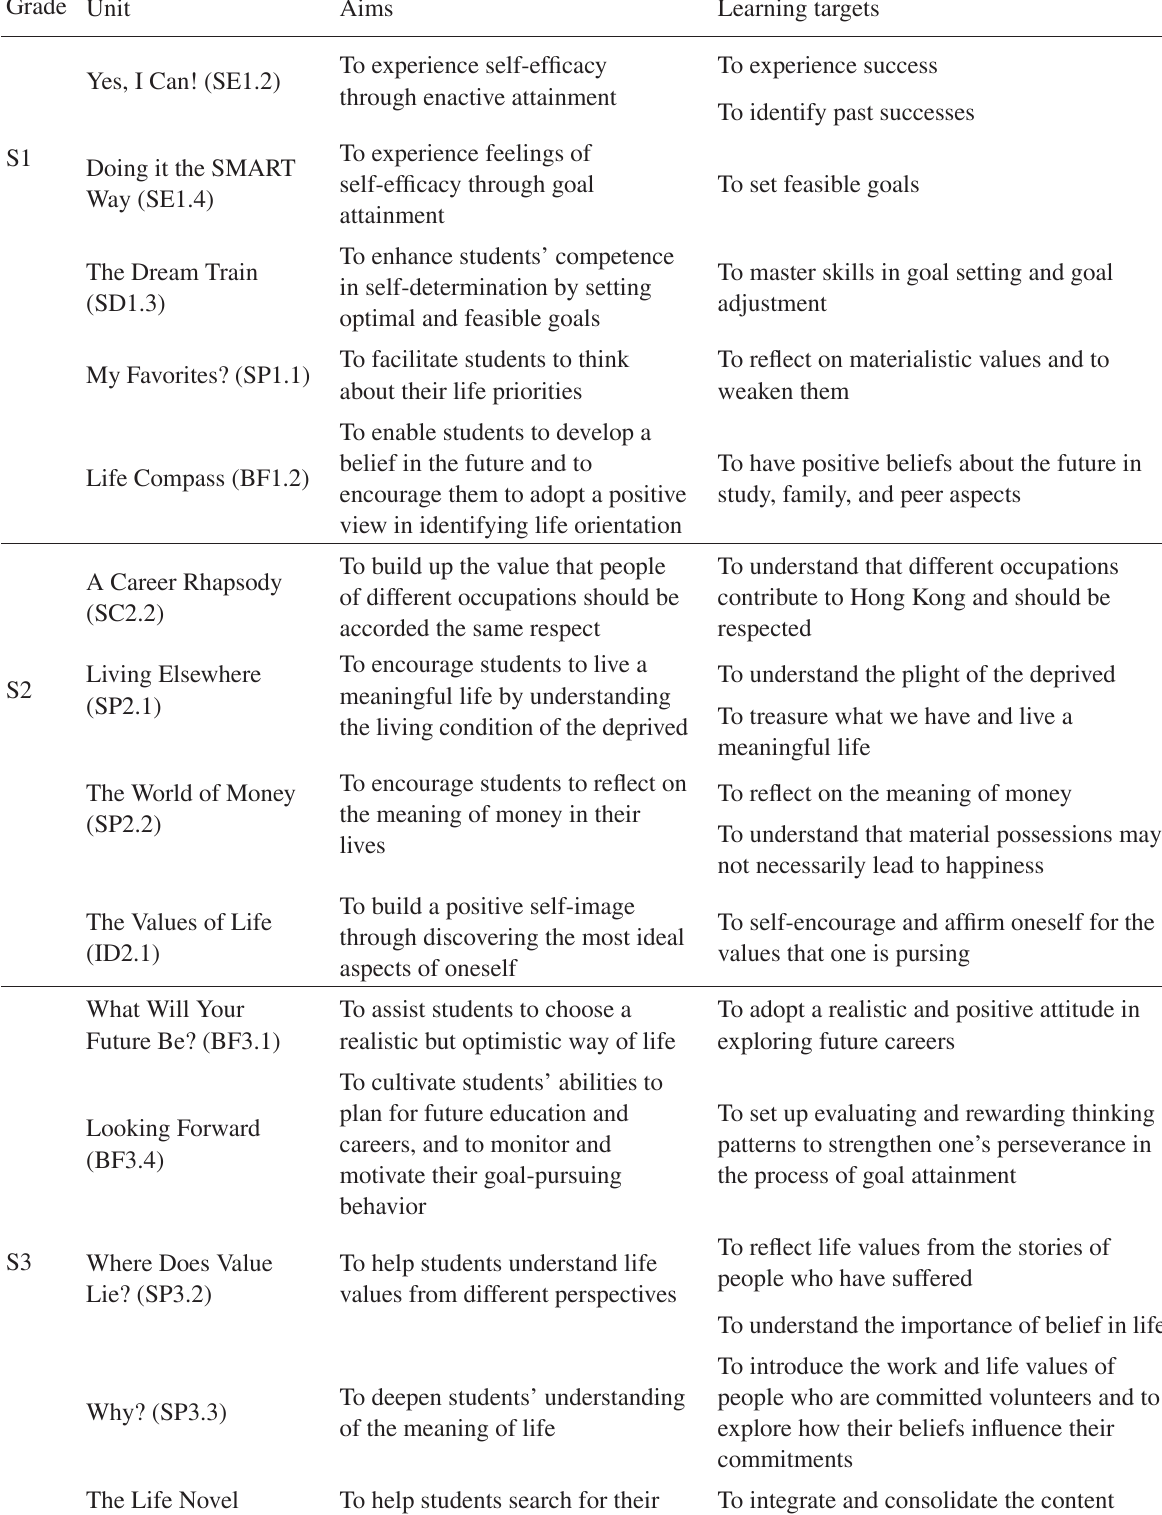
TABLE 1: Aims and learning targets of P.A.T.H.S. I curriculum units related to “Money and Success.” Grade